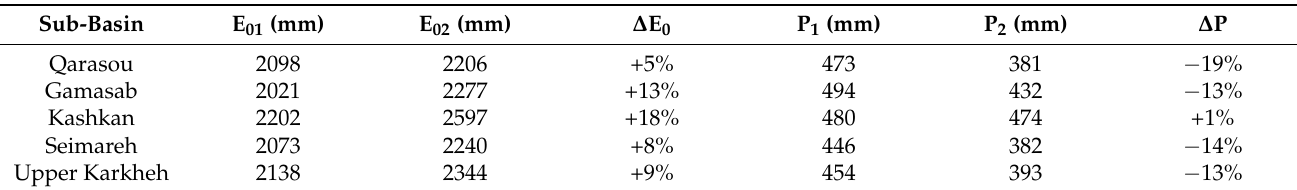
Table 3. E 0 and p variation during the pre- and post-change periods. Numbers 1 and 2 denote the pre- and post-change period, respectively.